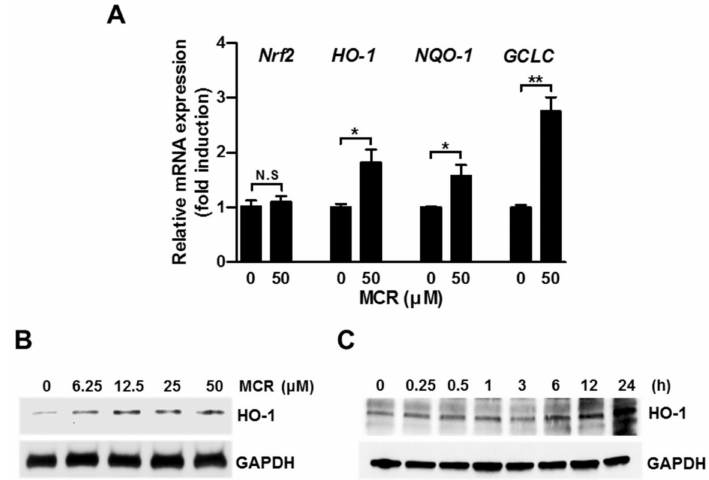
Figure 3. MCR induces Nrf2 target genes in HaCaT cells. ( A ) HaCaT cells were treated with 50 µ M of MCR for 12 h, and the expression of Nrf2 target genes was measured using the qPCR method; ( B ) Cells were treated with different concentrations of MCR for 24 h, and lysates were subjected to western blot analysis; ( C ) Cells were treated with 50 µ M of MCR for the indicated time periods, and whole cell lysates were subjected to western blotting. GAPDH was used as the loading control. * p < 0.05, ** p < 0.001; N.S., not